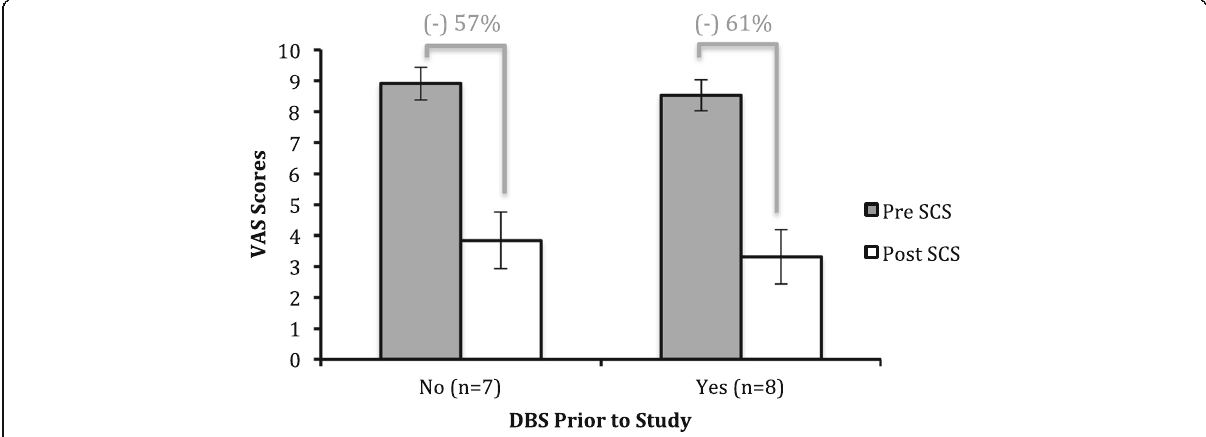
Fig. 1 Pre and Post VAS Scores Stratified by DBS Prior to Study